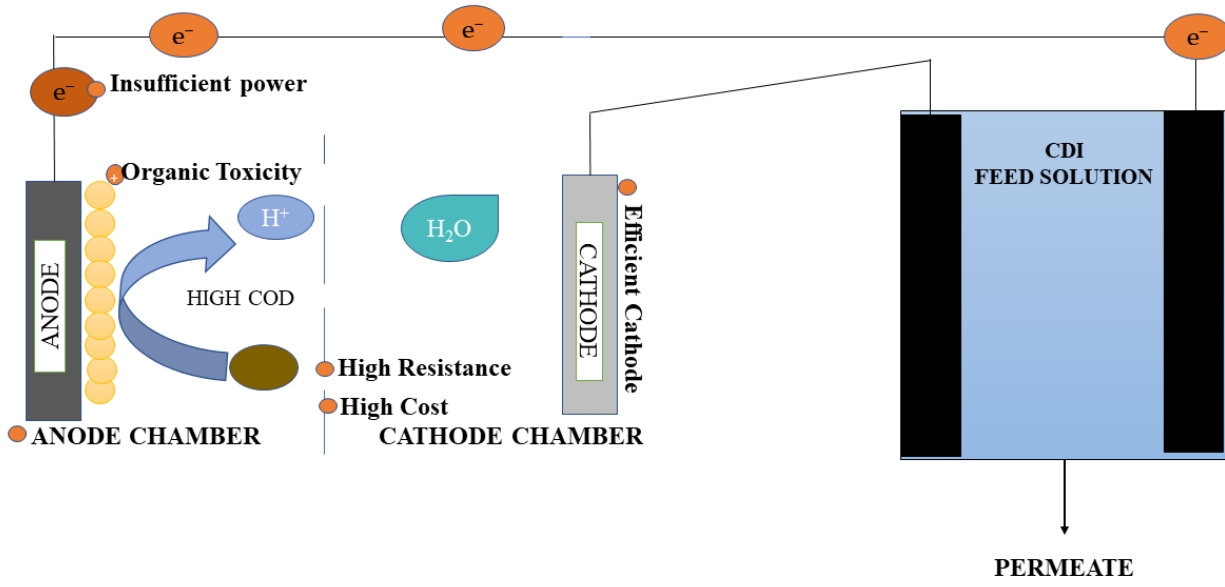
Figure 2. MFC-capacitive deionization (MFC-CDI) system.